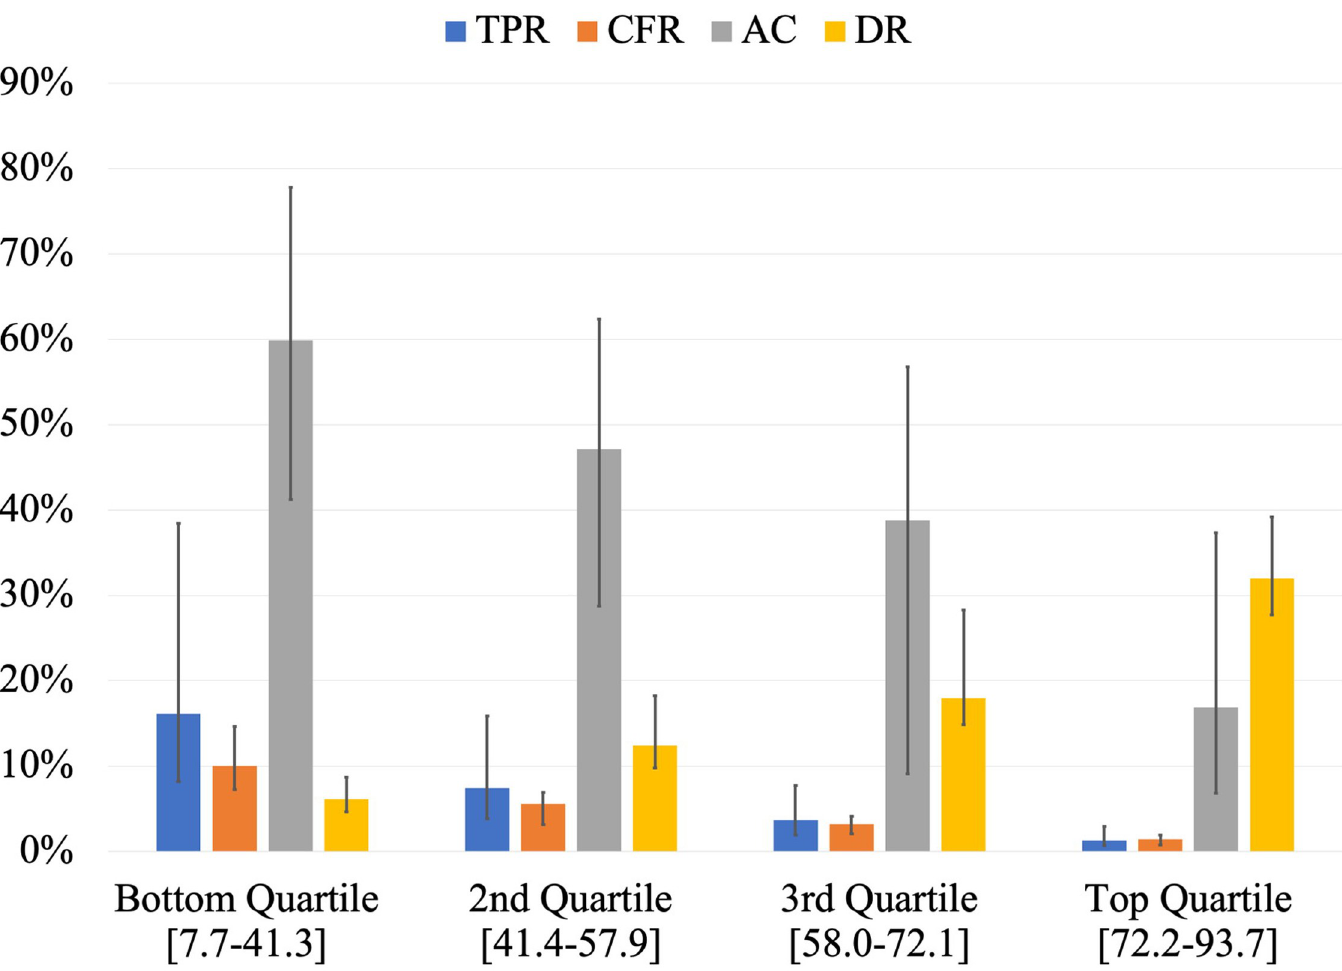
Fig 3. Comparison of the medians of Test Positivity Rate (TPR), Case Fatality Rate (CFR), proportion of Active Cases (AC), and Detection Rate (DR) among the quartiles of COVID-19 Testing Index (CovTI). Bottom quartile included the lowest 25% of CovTI values (n = 42), 2 nd quartile included CovTI values between 25 th and 50 th percentiles (n = 41), 3 rd quartile included CovTI values between 50 th and 75 th percentiles (n = 41), and the top quartile included highest CovTI values above 75 th percentile (n = 41). Values in brackets indicate the range of CovTI values in each quartile. Error bars represent interquartile range. Data per 00:00 GMT June 3, 2020.